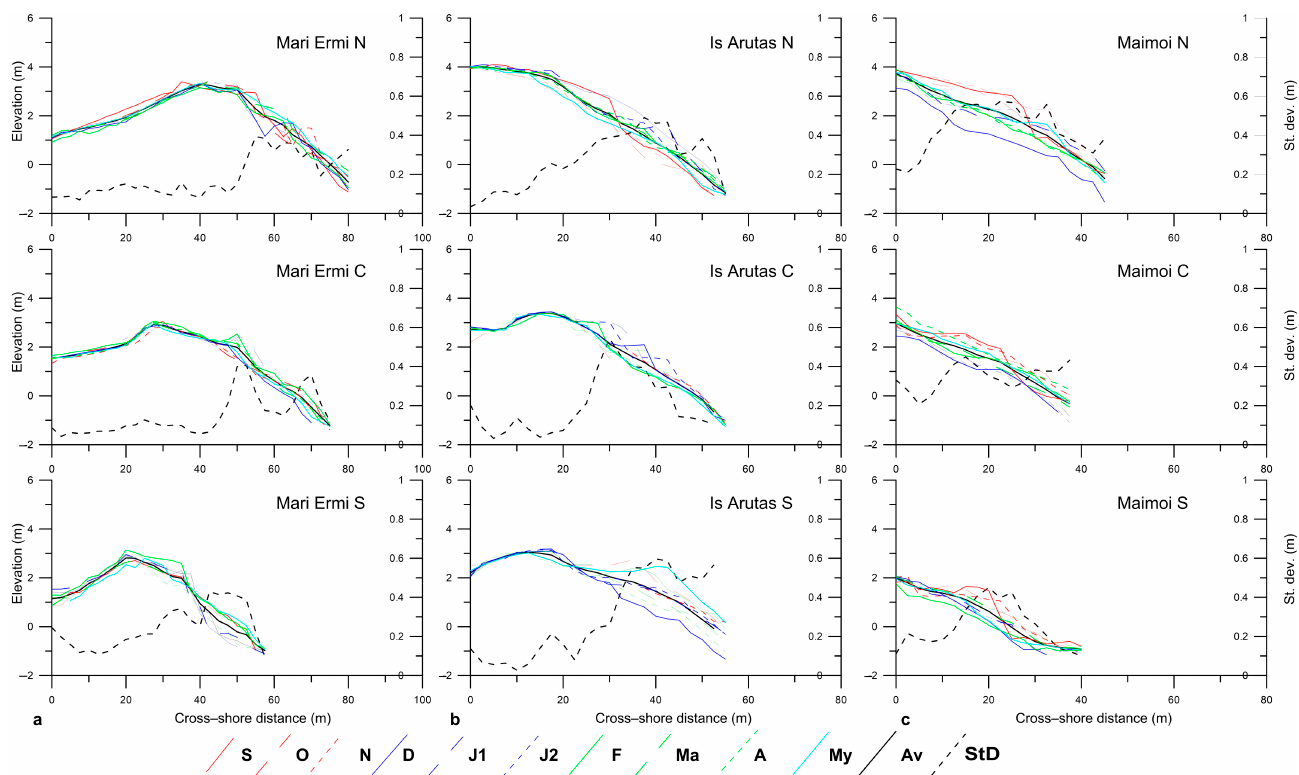
Figure 4. A plot of profiles acquired along the following investigated beaches: ( a ) Mari Ermi; ( b ) Is Arutas; and ( c ) Maimoi. S = 23 September 2010, O = 22 October 2010, N = 5 November 2010, D = 14 December 2010, J1 = 4 January 2011, J2 = 17 January 2011, F = 7 Februay 2011, Ma = 4 March 2011, A = 14 April 2011, My = 13 May 2011. The continuous black line is the mean beach profile, the dashed black line is the value of standard deviation; N = north profile, C = center profile, S = south profile.